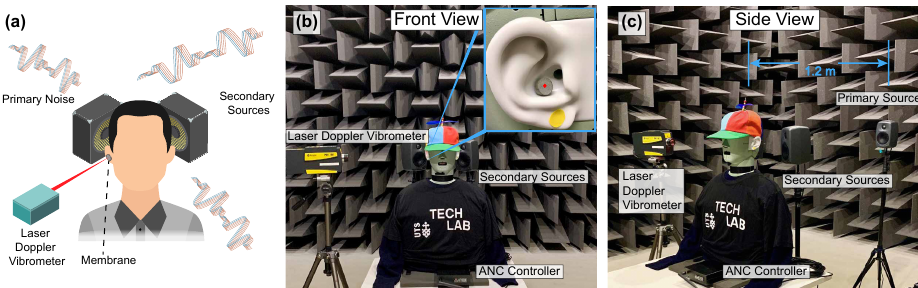
Figure 12. ( a ) Schematic of the presented acoustic sensing apparatus used for ANC where a retro- reflective membrane is placed in one of the user’s ears and the LDV measures the vibration of the membrane as the error signal. ( b ) Front view and ( c ) side view of the experimental setup.